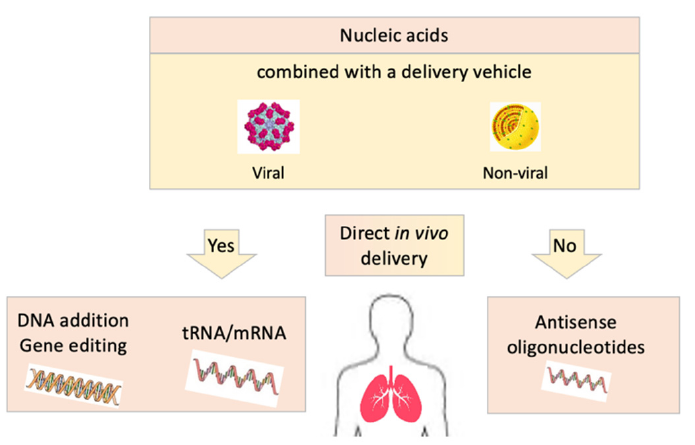
Figure 1. Different strategies of direct in vivo delivery of nucleic acid-based therapies in cystic fibrosis: modified nucleic acids combined or not to a delivery vehicle are administered in vivo in patients.